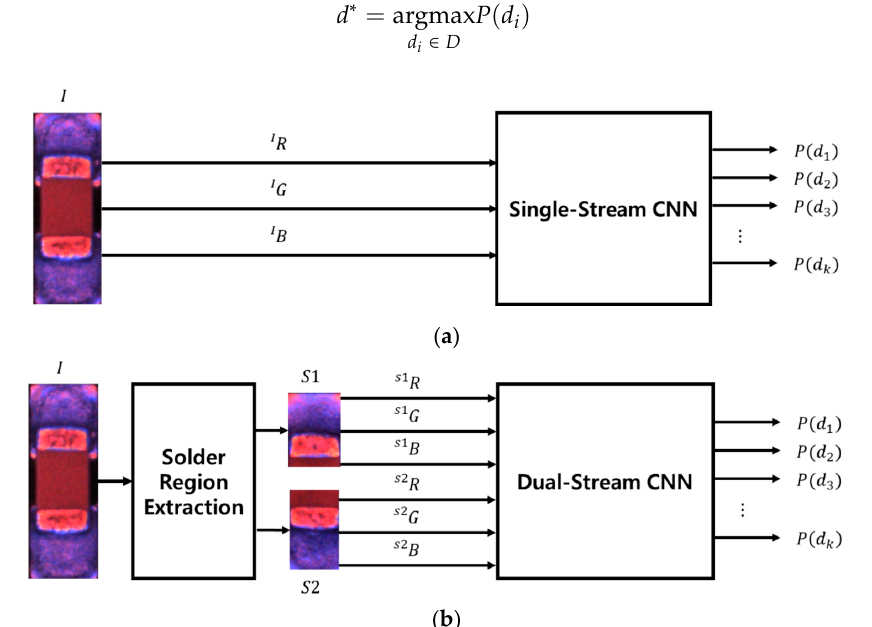
Figure 4. Input and output structures of convolutional neural networks (CNNs) for defect classification: ( a ) single-stream CNN; ( b ) dual-stream CNN.